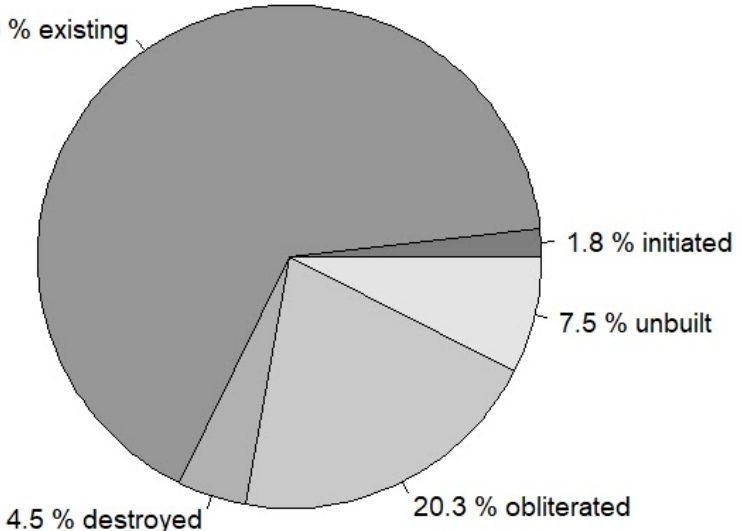
Figure 3. Percentage of the current structural and technical condition of A-CEFs (respectively UA-CEFs) in the Moravian-Silesian Region ( n = 896). Table 1. Summary table of SA-CEFs within each section for further data